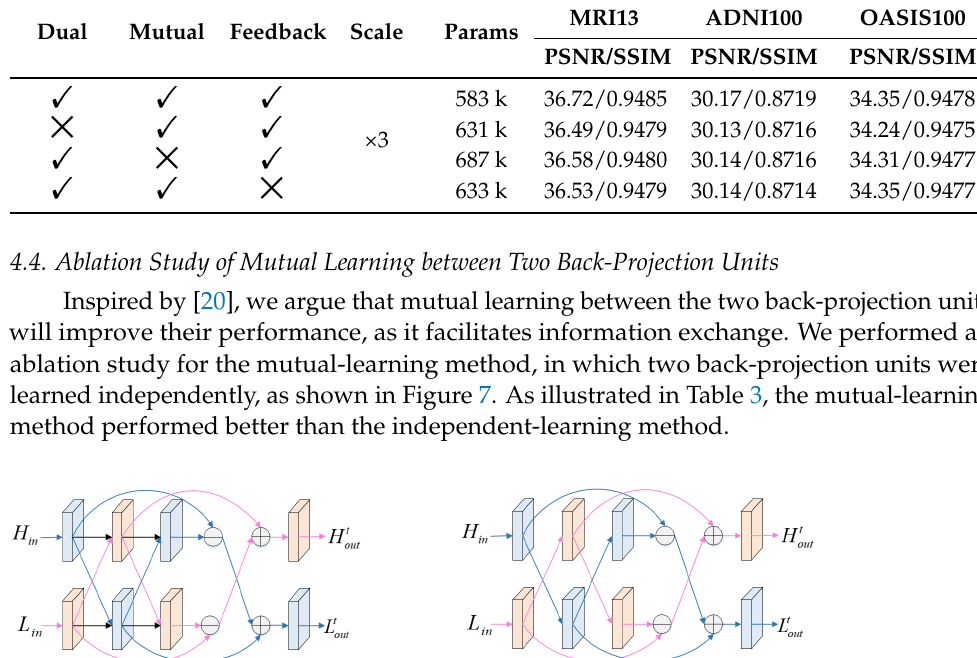
Table 2. The ablation studies of dual feedback, mutual feedback, and feedback on DMFN.